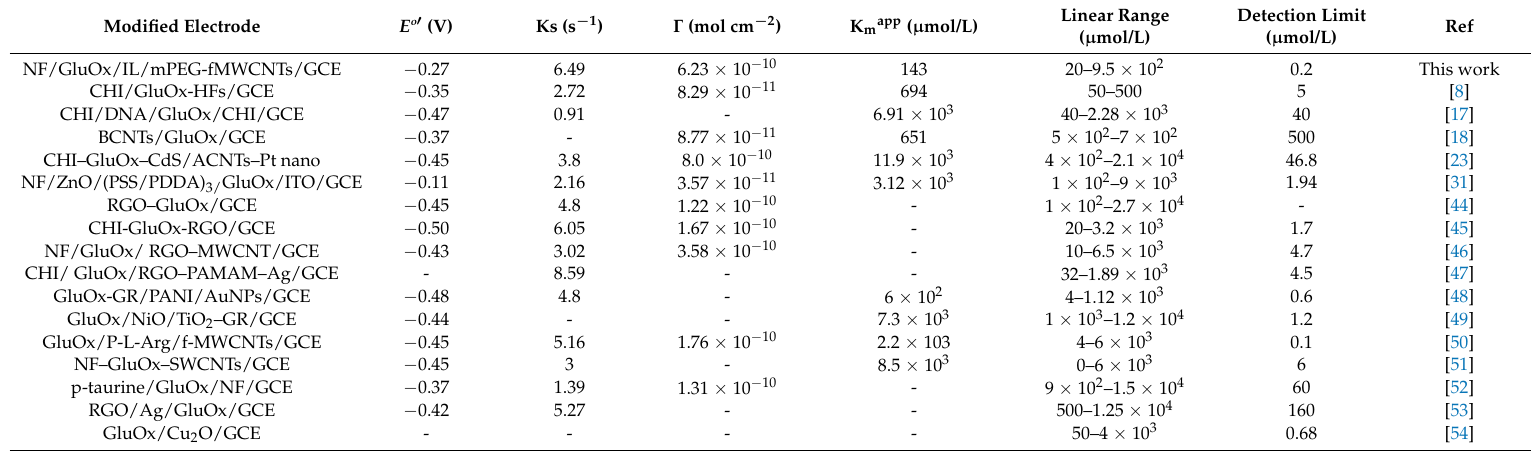
Table 1. Electrochemical parameters of the electrodes recently modified for glucose detection. Modified